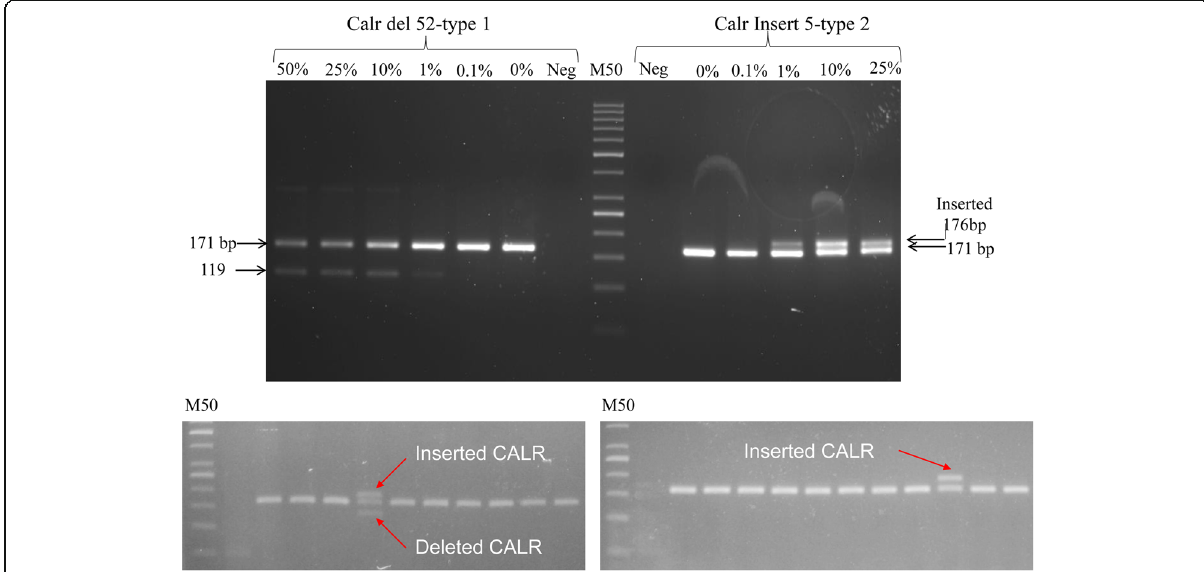
Fig. 4 CALR genotyping and Limit of detection by PCR- ALDA. Dilution series were made by mixing 50% deleted CALR (upper left panel) or inserted CALR (upper right panel) containing DNA samples against wild type DNA. The dilution series were subjected to PCR-ALDA in which only one primer pair is used to unbiasedly amplify wild-type CALR allele and CALR mutant alleles. Subsequently, the reaction mixture was electrophoresed on a 2.5% agarose gel. The 171 bp-CALR-wild-type-allele against the 119 bp (type 1) 52 bp deleted CALR allele or 5 bp TTGTC inserted type − 2 mutation allele or other deleted and inserted alleles. Lower panel- CALR mutations in selected clinical samples: arrows indicate